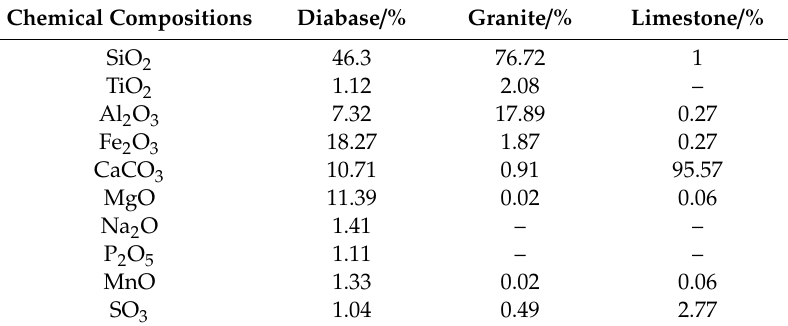
Table 5. Chemical compositions (wt%) of the coarse aggregates.